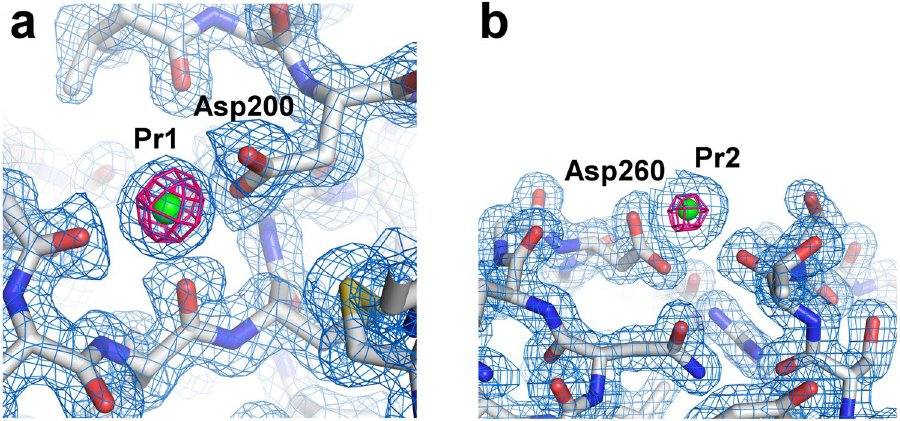
Figure 3. Electron density maps of proteinase K. ( a,b ) Close-up views of Pr ion binding sites with 2 F o – F c electron density maps contoured at the 1.0 σ level (coloured blue). Bound Pr ions are depicted as a green sphere. The anomalous difference Fourier maps using 3,000 images (contoured at the 6.0 σ level) are shown in magenta. These figures were drawn with PyMol (http://www.pymol.org).